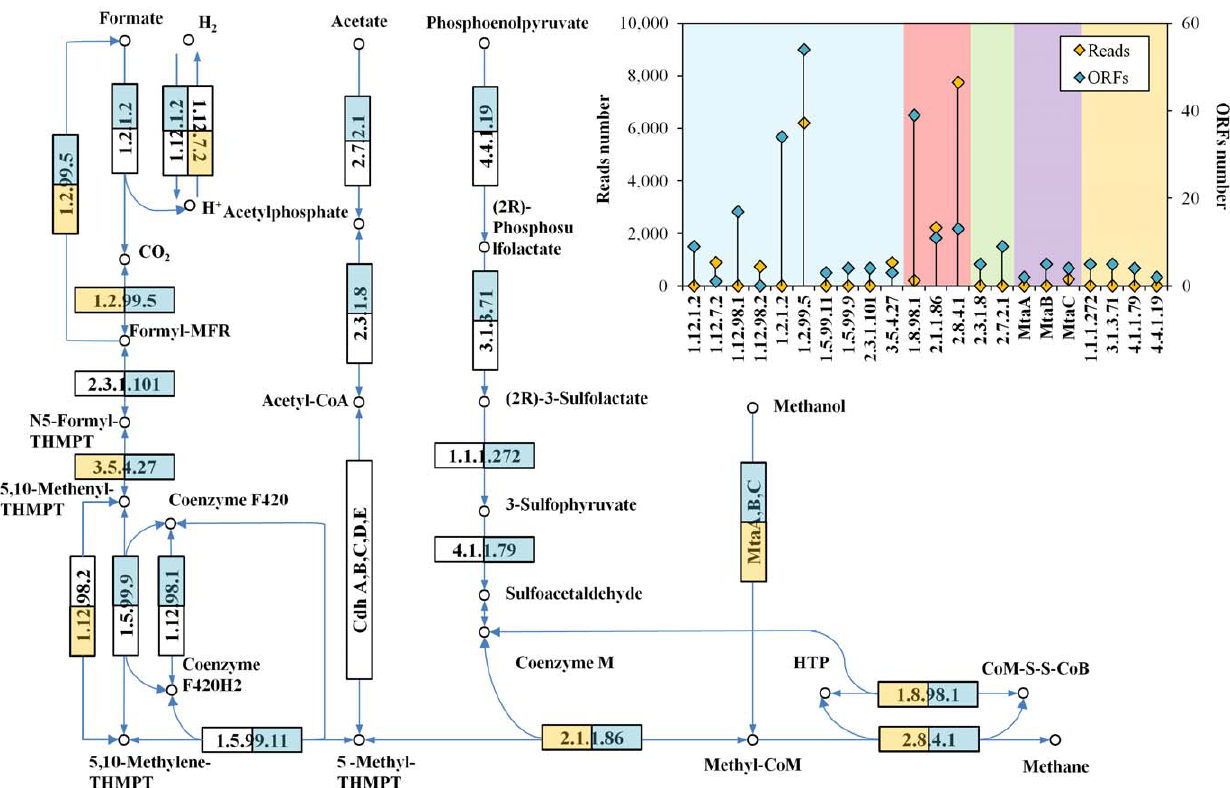
Figure 3. ORF and Reads assignment to KEGG Methanogenesis Pathway. Blue square indicates this enzyme has at least one ORF assigned; Yellow square indicates this enzyme has at least one read assigned. Insert: numbers of ORFs and reads assigned to enzymes in the pathway. Metabolism modules are highlighted in different colors: blue, ‘‘Formate to Methane’’; green, ‘‘Acetate to Methane’’; purple, ‘‘Methanol to Methane’’; yellow, ‘‘Coenzyme M synthesis’’; red, enzymes shared among different